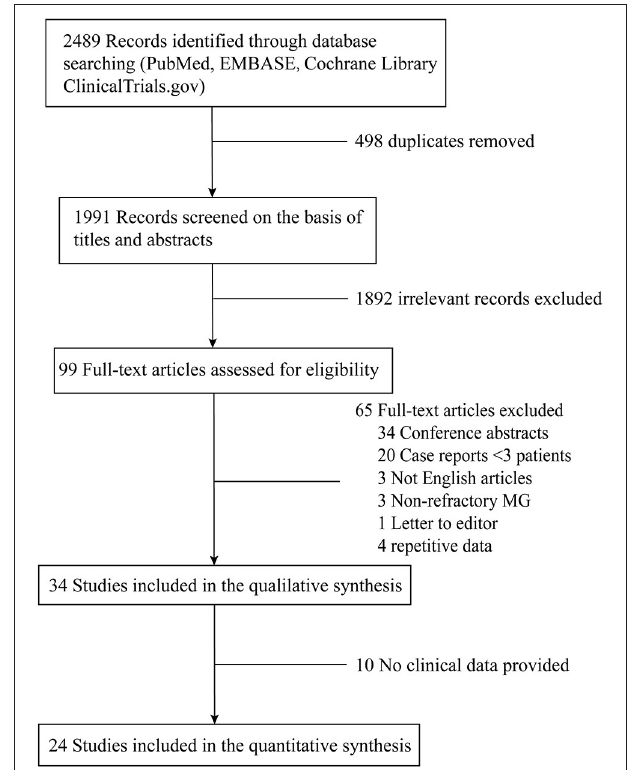
FIGURE 1 | Flow chart of study selection algorithm according to PRISMA